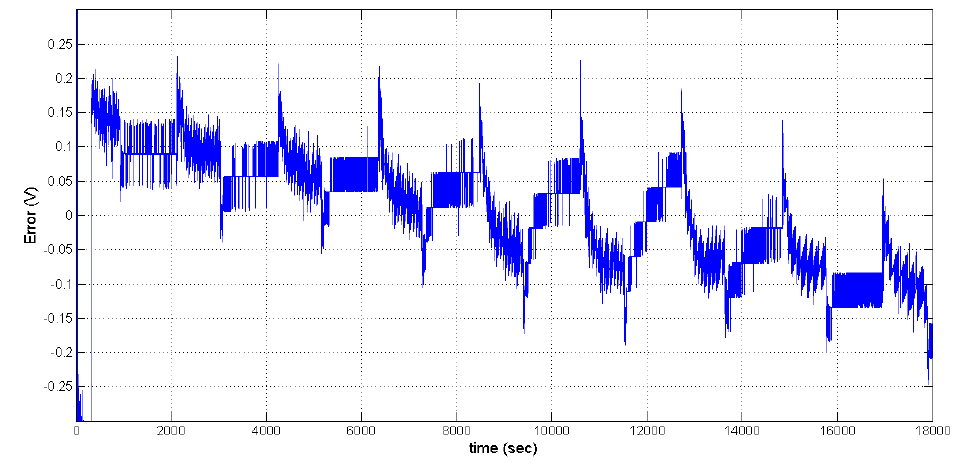
Figure 15. The error between the real model and the simulated one under HPPC.